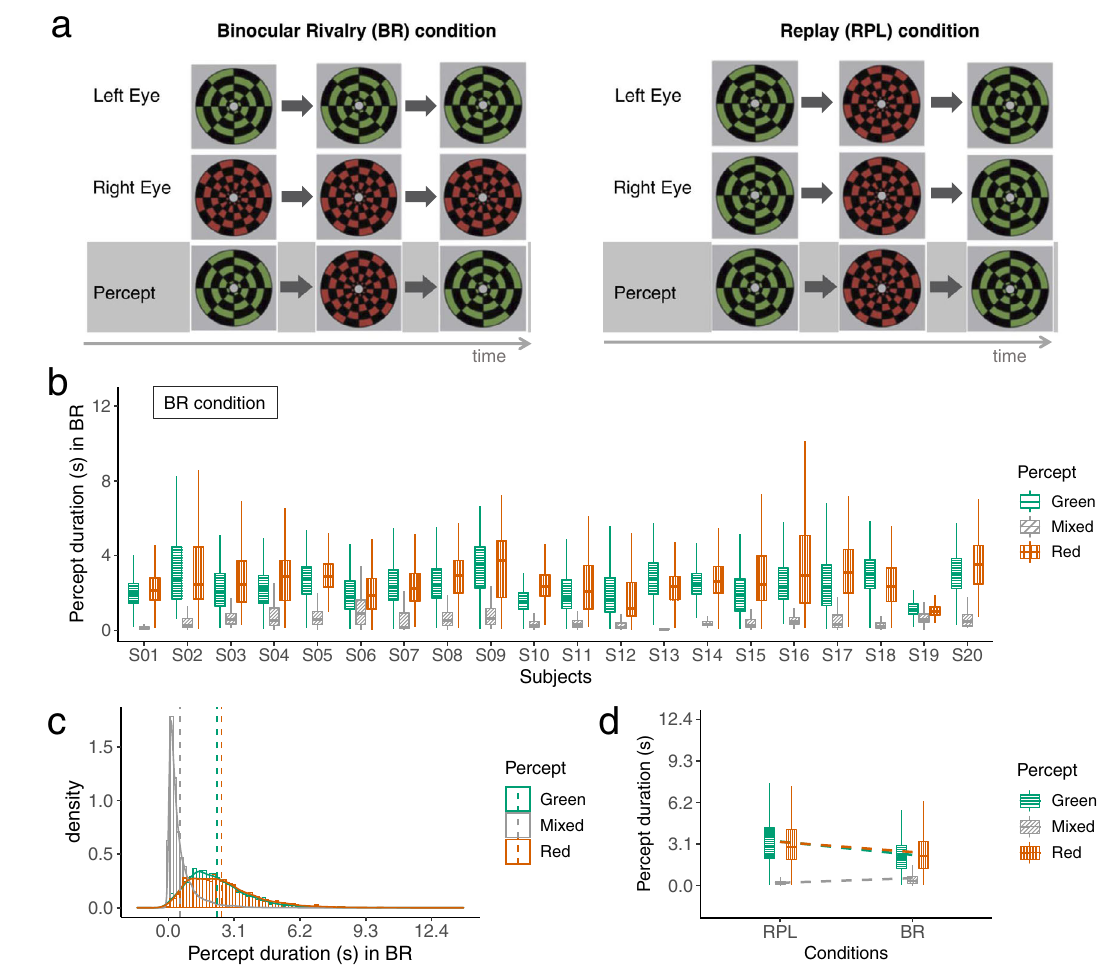
Fig. 1 | Experimental design with 2-by-2 conditions of different percepts and ways of percept generation. a Experimental schema adapted from the original study from which the data was shared 38 . During the binocular rivalry (BR) blocks (left), the participants were presented with different images, each for one eye, in thecentreofthevisual fi eld.Duringthereplay(RPL)blocks(right),theparticipants were presented with the same image for both eyes, and this image alternates over time between red, green via a short superimposition. The purpose of the RPL condition isto simulate the perceptual experienceinthe BRconditionbut without